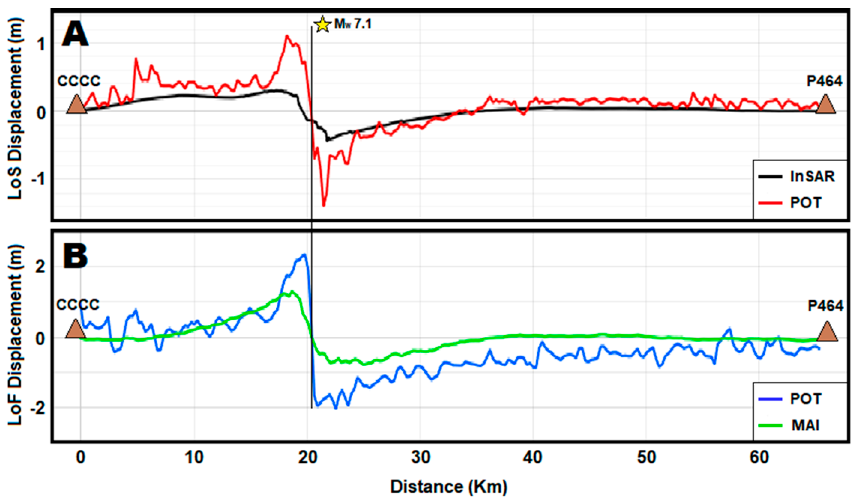
Figure 4. InSAR, MAI and POT data profiles along the transept connecting the CCCC and P464 GNSS stations: LOS InSAR and POT displacement ( A ) and LOF MAI and POT displacement ( B ).